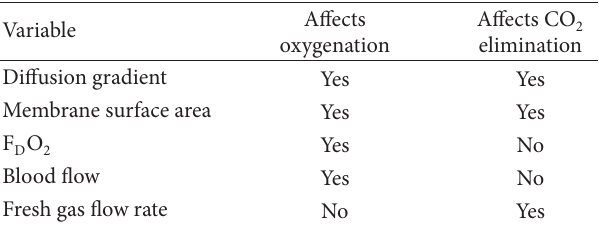
Table 3: Similarities and differences between VA ECMO oxygena- tion and